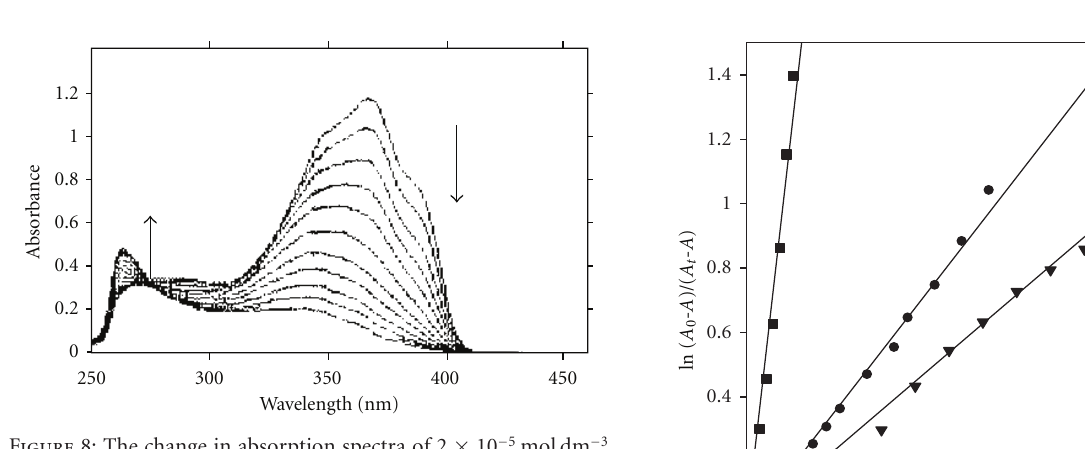
Figure 8: The change in absorption spectra of 2 × 10 − 5 moldm − 3 of POPOP in CCl 4 as a result of UV irradiation ( λ ex = 366 nm). The irradiation times at decreasing absorbance are 0.0, 1, 2, 3, 4, 5, 6, 7, 8, 10, and 11 min.